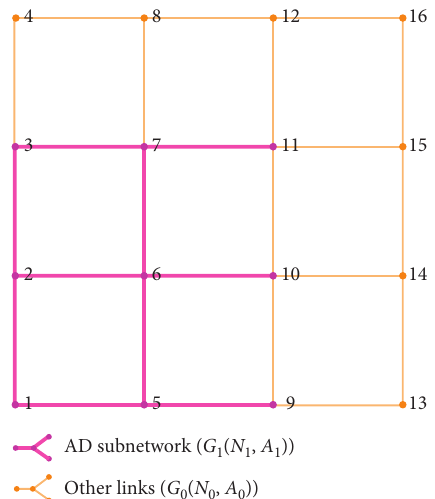
Figure 2: An example AD subnetwork. Nodes 3-7-9-10-11 are boundary nodes, links (5,9)-(6,10)-(7,11) are inner boundary links, and links (9,13)-(10-14)-(11,15)-(11,12)-(7,8)-(3-4)-(9,10)-(10,11) are outer boundary